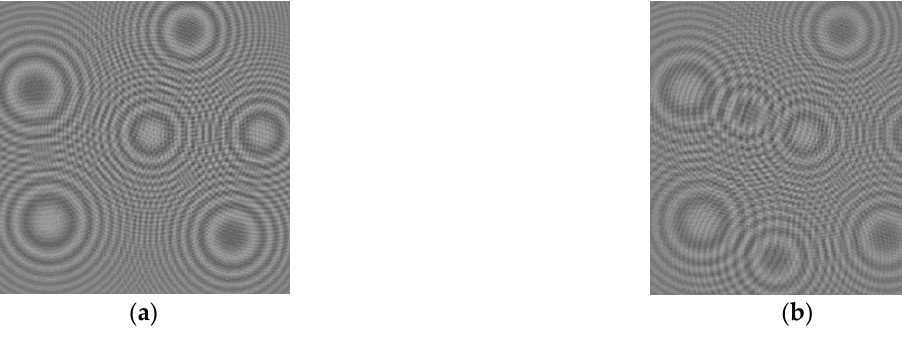
Figure 3. Two artificially generated 2-D mixed multiple fringe patterns composed of ( a ) six and ( b ) eight circular fringe patterns.